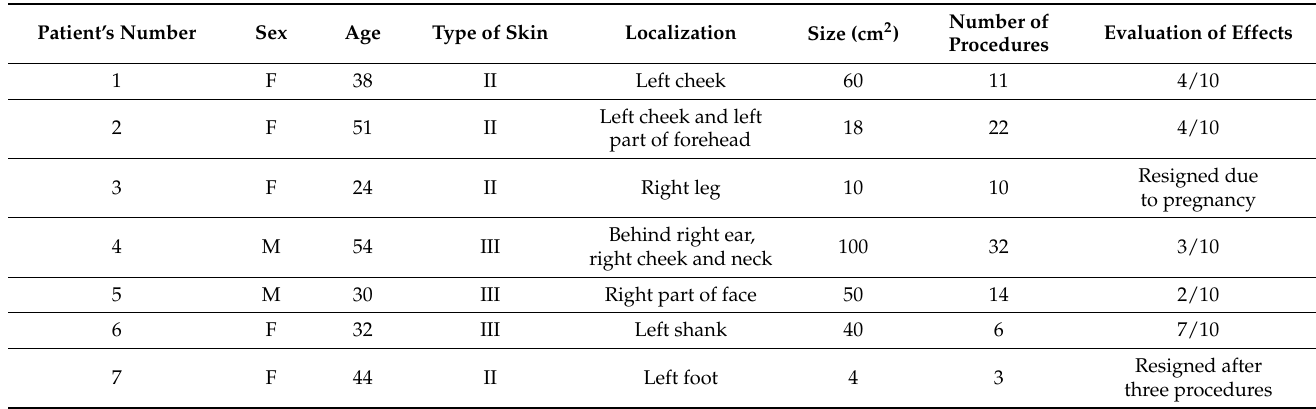
Table 2. Data for the patients with pink